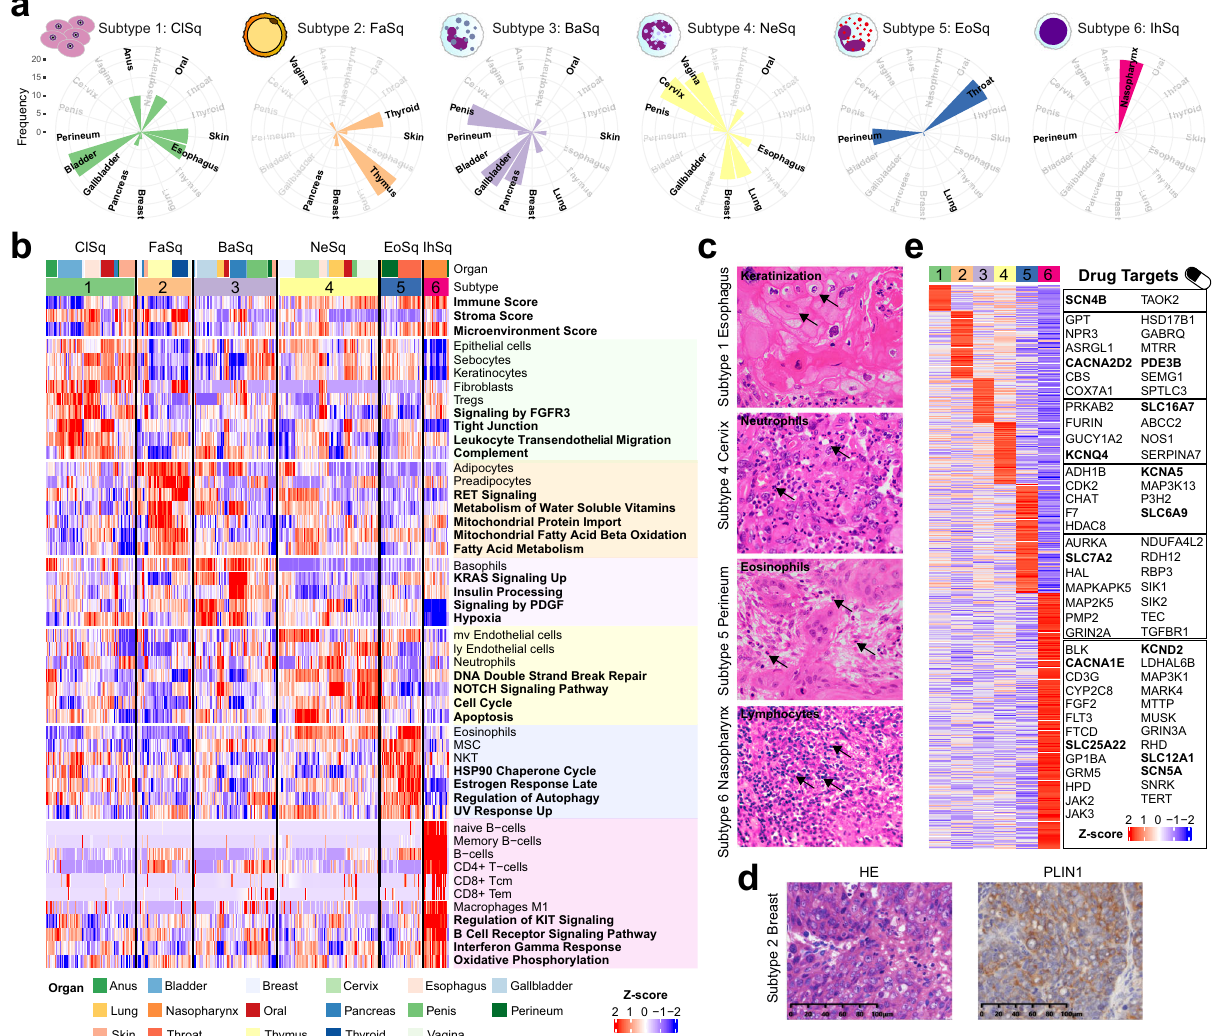
Fig. 5 Immune-based subtyping of pan-SCCs. a Coxcomb diagrams showing the distribution of 17 SCCs in 6 subtypes, including (1) Classical squamous (ClSq), (2) Fatty acid metabolic (FaSq), (3) Basophils in fl amed (BaSq), (4) Neutrophils in fl amed (NeSq), (5) Eosinophils in fl amed (EoSq), and (6) Immune hot (IhSq). b Proteome-based microenvironmental cell signatures and over-represented pathways in 6 subtypes. c Represented morphologies of SCCs with speci fi c tumor microenvironment cell in fi ltrating in 4 subtypes (subtype 1, 4 – 6). Arrows depict the speci fi c cell types. Basophils were not shown because they cannot be recognized by HE staining. Scale bar, 100 μ m. d Haematoxylin and eosin (H&E) stained and PLIN1 immunohistochemistry (IHC) images showing one example of subtype 2 samples with suspected lipid droplets. e Drug targets in 6 subtypes (drug targets discussed in the text were in